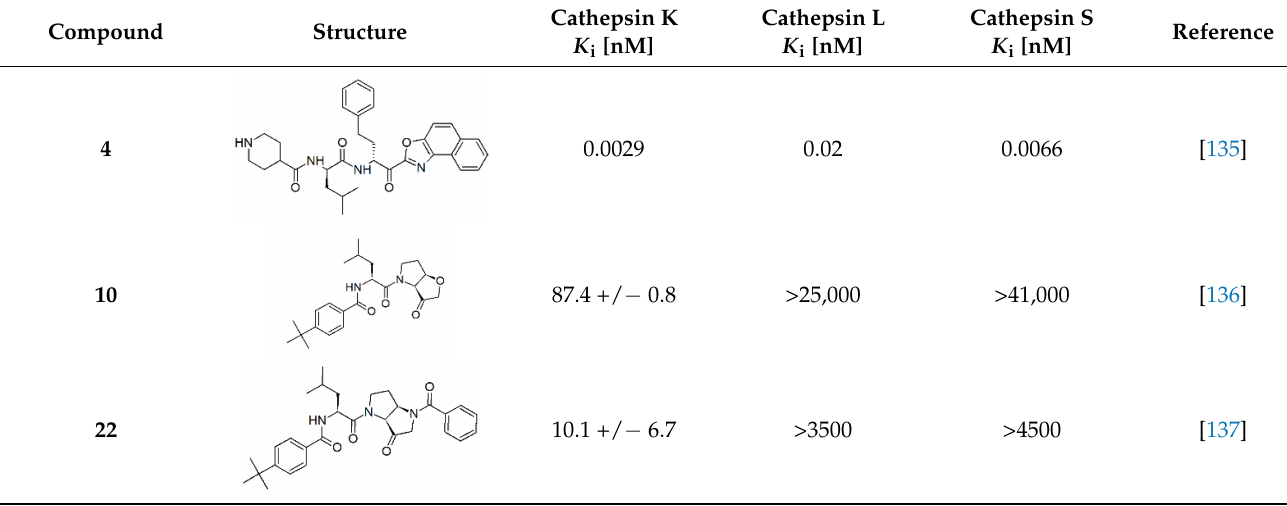
Table 6. Structures and K i values in nM obtained for heterocyclic peptidomimetics, synthesised and evaluated against various cathepsins. Results for CatK, L, and S are evidenced.